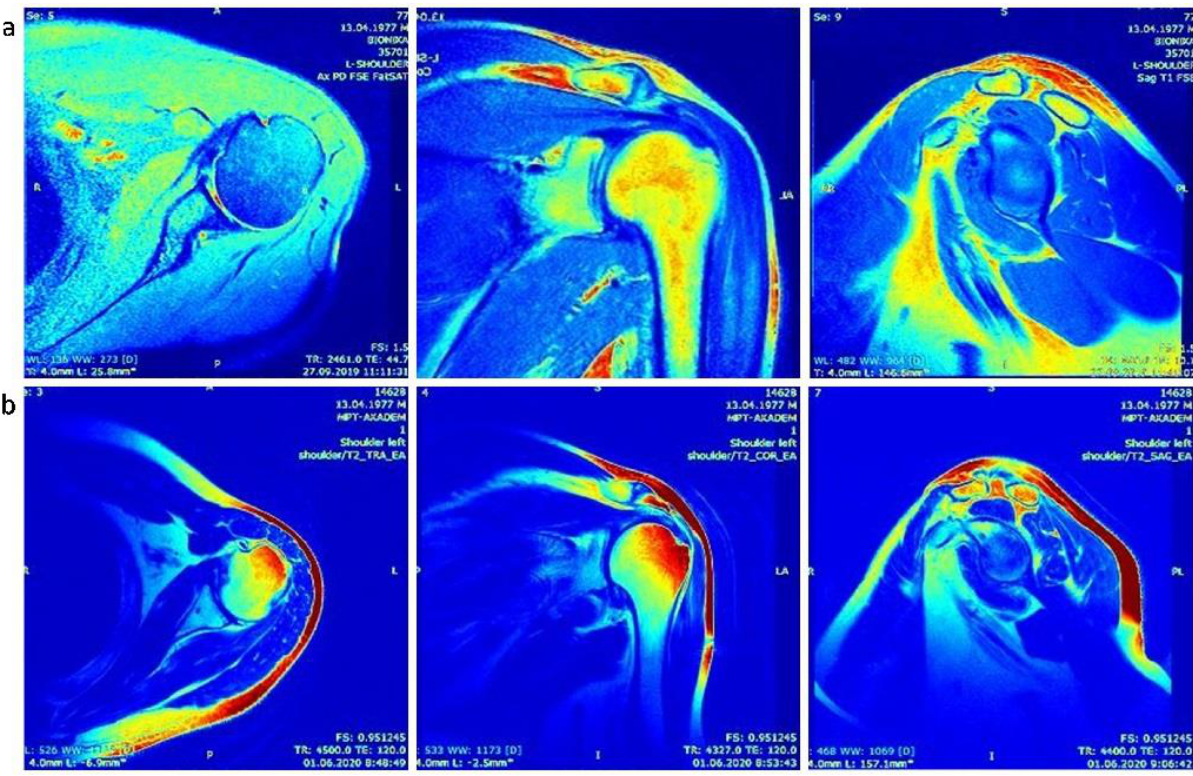
Figure 7. Examples of the MRI image processing with SLAP injury and partial rupture of the supraspinatus tendon: (a) before surgery; (b) 1 month after